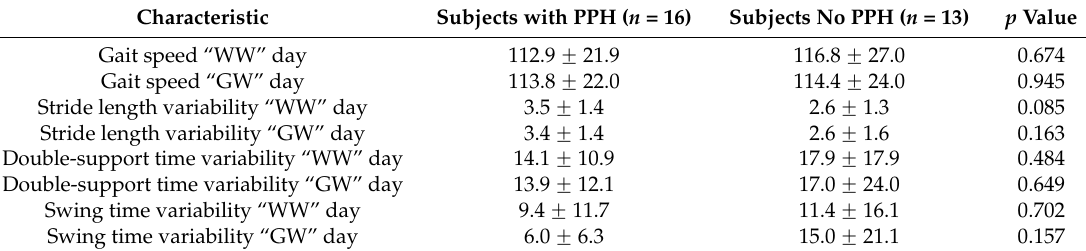
Table 3. Baseline gait